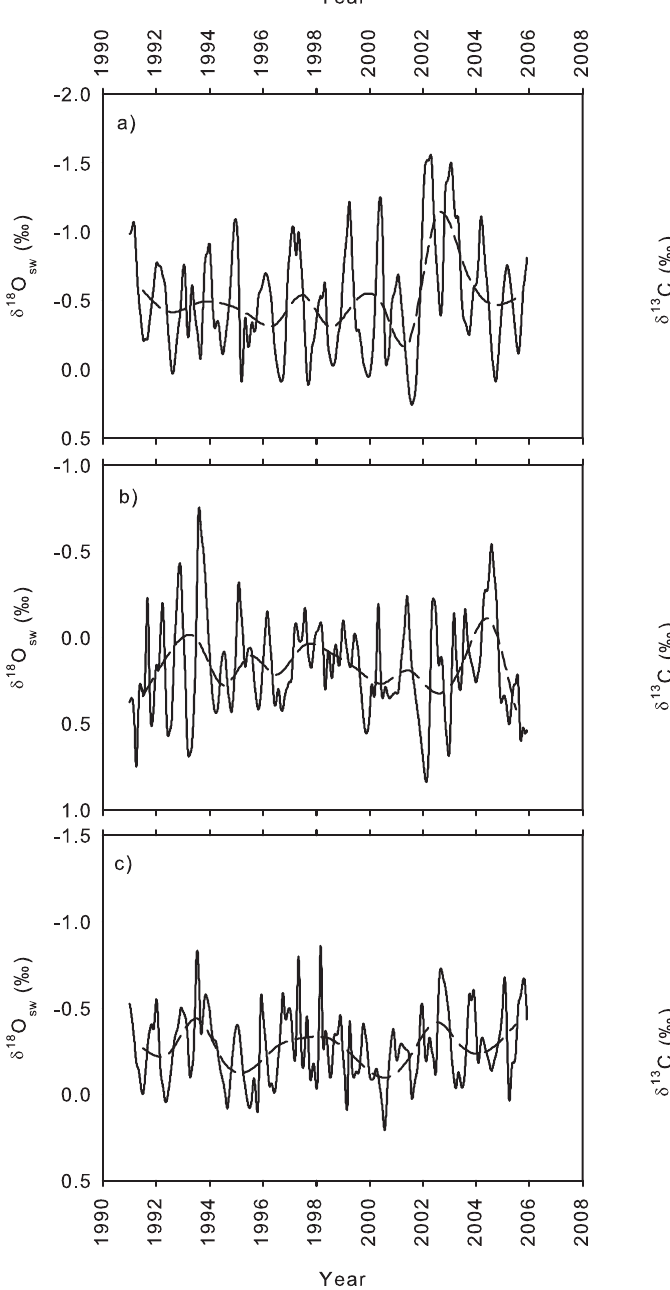
Fig. A3. The δ 18 O seawater ( δ 18 O sw ) of coral cores MAS1 (a) , AN- DRA (b) and IFAHO (c) calculated by subtracting the thermal com- ponent from coral skeletal δ 18 O based on the relative changes in Sr/Ca-SST following Ren et al. (2002). The annual average (dashed line) values were calculated by averaging the months January to De- cember for each of the 15yr.